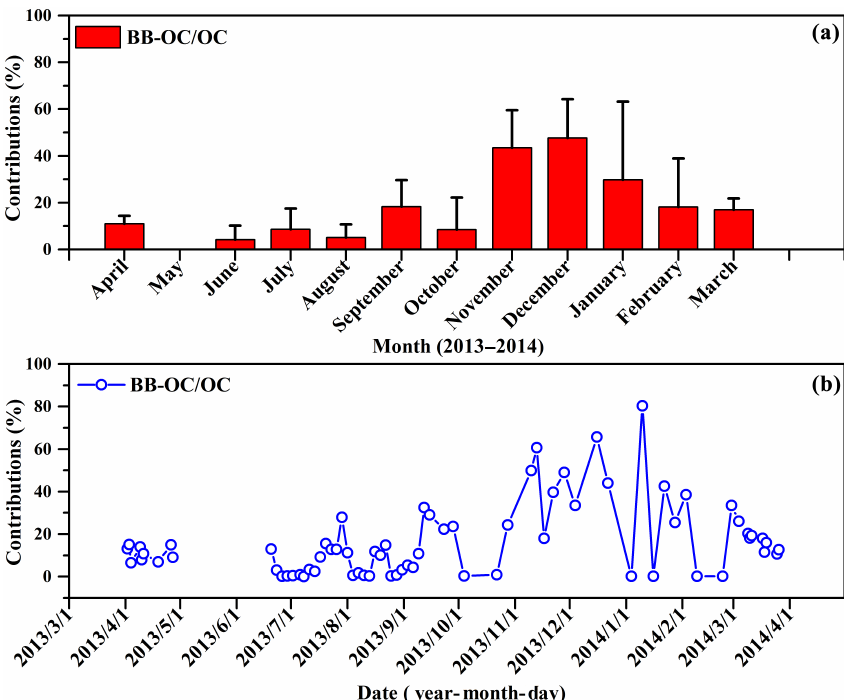
Figure 8. (a) Monthly and (b) temporal variations in the contributions of biomass burning organic carbon (BB–OC) to organic carbon (OC) calculated from the diagnostic tracer ratio of lev / OC. The data of May 2013 are missing due to equipment